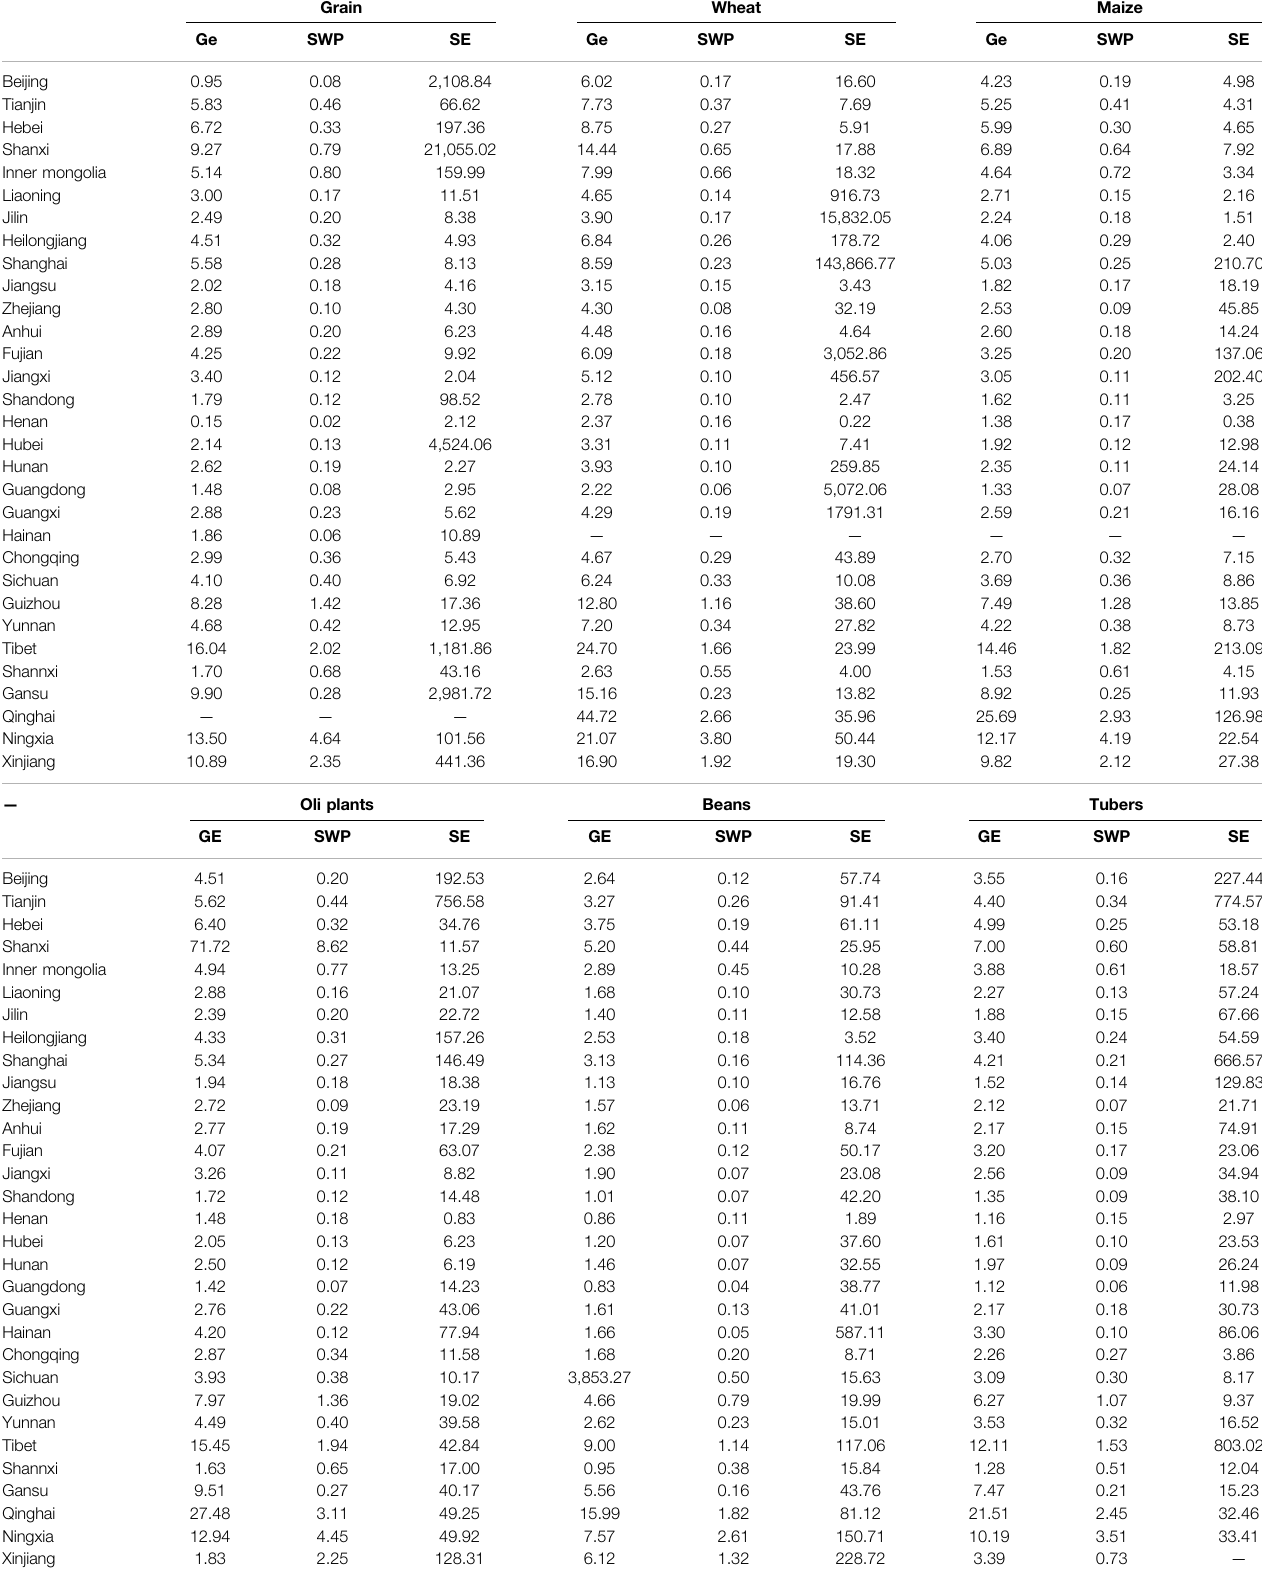
TABLE 4 | The eco-ef fi ciency (EE) of each crop in 31 provinces. Grain Wheat Maize Ge SWP SE Ge SWP SE Ge SWP SE